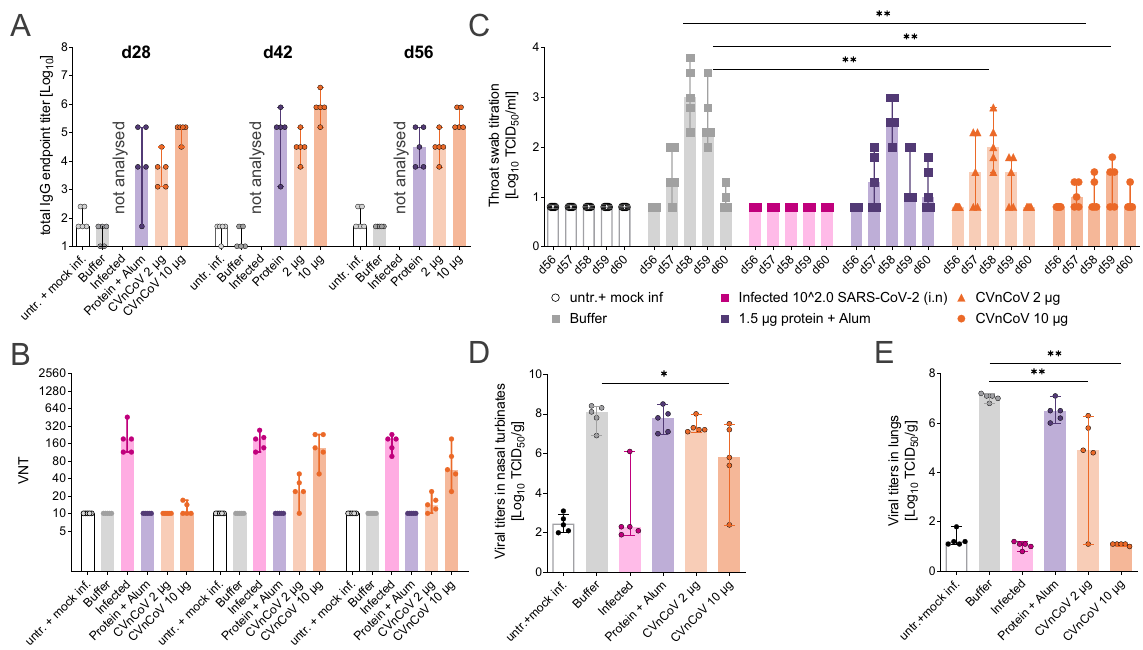
Fig. 4 CVnCoV protects hamsters from SARS-CoV-2 challenge infection. Female Syrian golden hamsters ( n = 5/group) were vaccinated with 10 or 2 µg of CVnCoV, 1.5 µg of Alum-adjuvanted S ECD protein or buffer on day 0 and d28. As additional controls, animals were either left untreated or infected intranasally (IN) with 10 2 TCID 50 /dose of SARS-CoV-2 on day 0 of the experiment. A Total IgG antibodies binding to S ECD displayed as ELISA endpoint titres of all groups except for infected animals that were not analysed or B VNTs determined via CPE-based assay upon one (day 28) or two vaccinations (day 42 and day 56). On day 56, all animals except for the untreated group were challenged by IN infection with 10 2 TCID 50 /dose of SARS-CoV-2 in a total dose volume of 0.1 ml. Animals in the untreated groups were mock infected with buffer as a negative control. Animals were followed for 4 days post challenge (p.c.) and euthanised on day 60 of the experiment. Detectable levels of replication-competent virus in C throat swabs on days 56 to day 60, D nasal turbinate on day 60 and E lung tissues on day 60 were analysed. Each dot represents an individual animal, bars depict the median. Statistical analysis was performed using Mann – Whitney